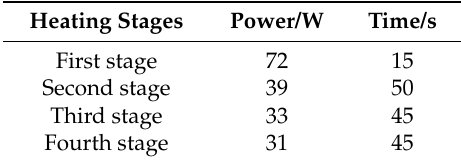
Figure 10. The device of Microwave heating: a MultiSYNTH microwave synthesizer. Table 5. Microwave heating procedure for a 4 g sample of the calcium-fortified milk systems.